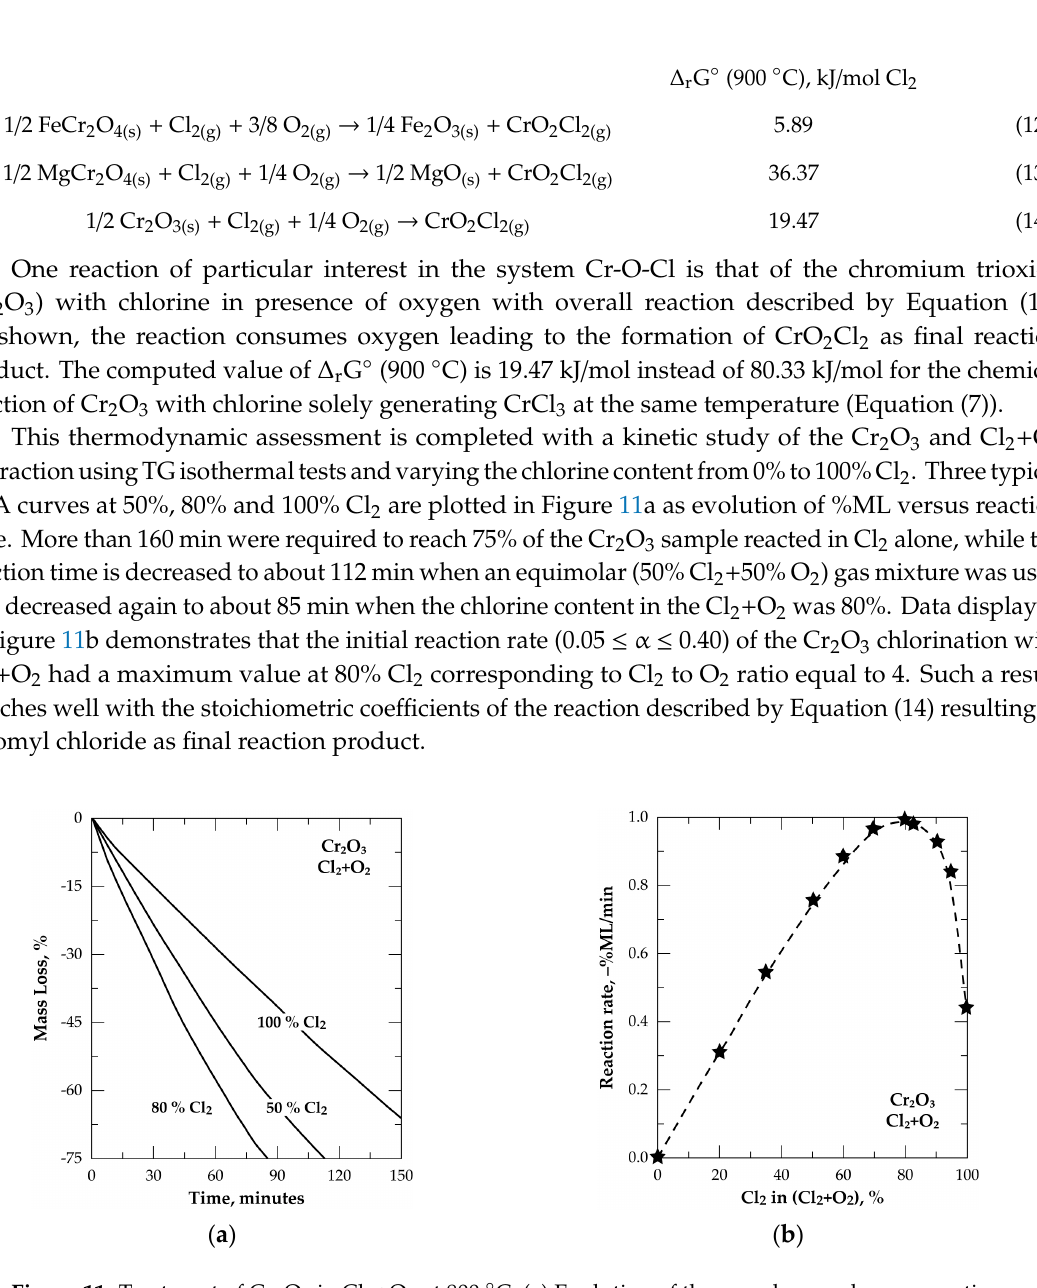
Figure 12. Mass change of the sample versus time for the treatment of LGChC in Cl 2 +air. For comparison, the acquired TG data for the reactions of LGChC and HGChC with chlorine in presence of oxygen are shown in Figure 13. The main observations are the high difference between %ML of HGChC and LGChC and the slope change of the %ML vs. time (ML rate), which is clearly more pronounced at 950 °C for both materials, although this evidence is also visible at 1025 °C.